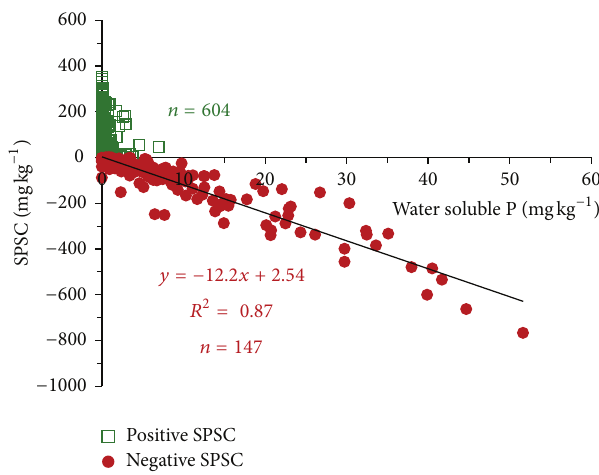
Figure 1: Relationship between soil P storage capacity (SPSC) and water soluble P for A and E horizons of manure-impacted soils. Source: Nair et al. [21].